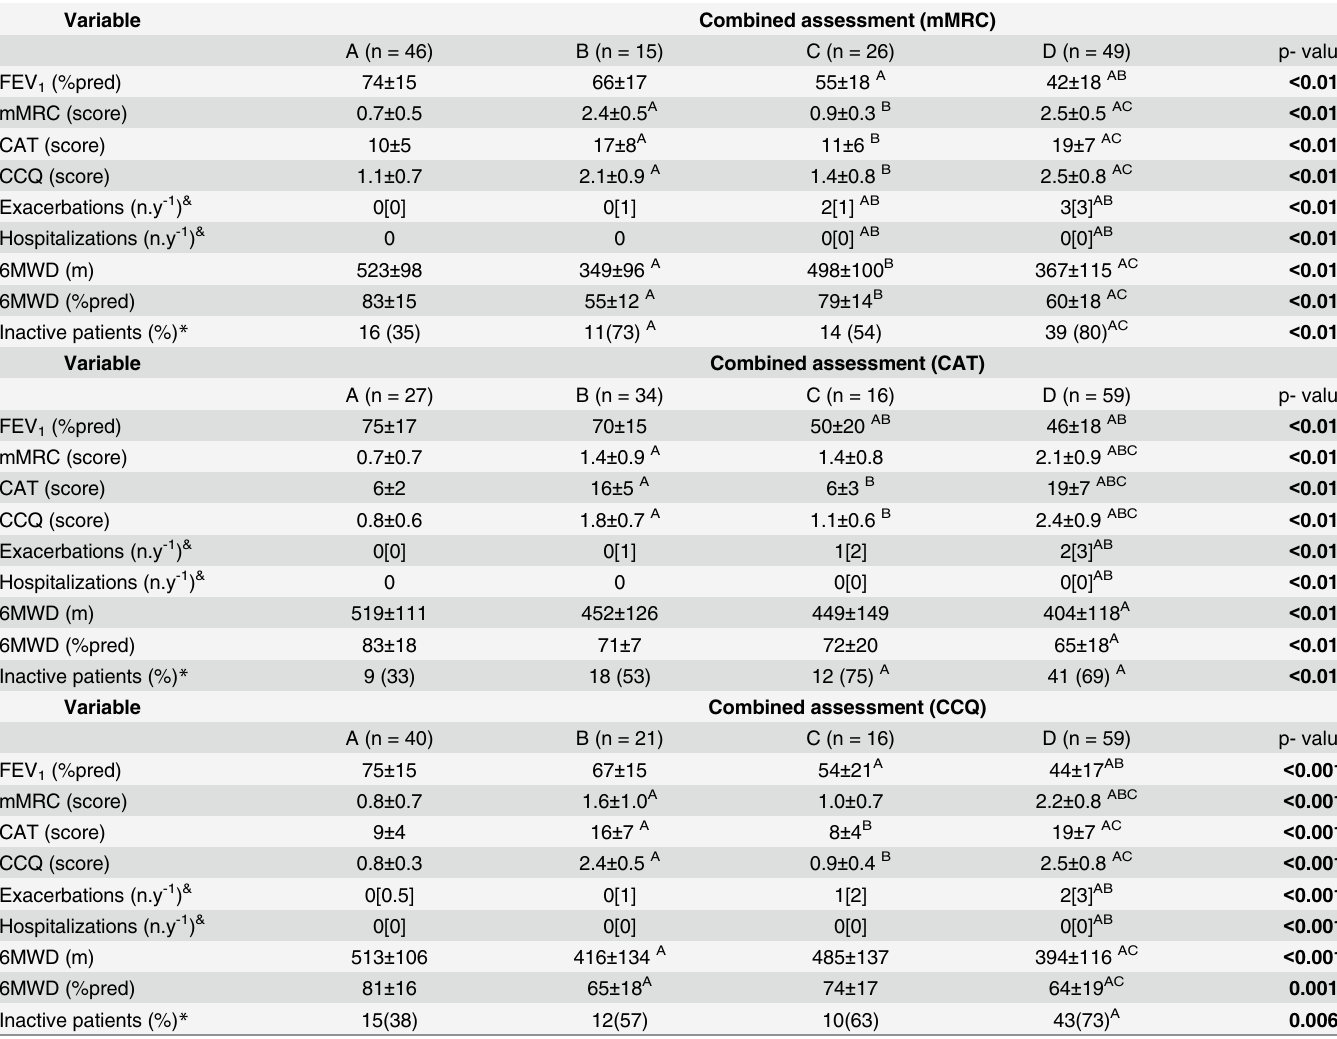
Table 2. Patient characteristics across the different GOLD quadrants using mMRC, CAT or CCQ score to define symptoms